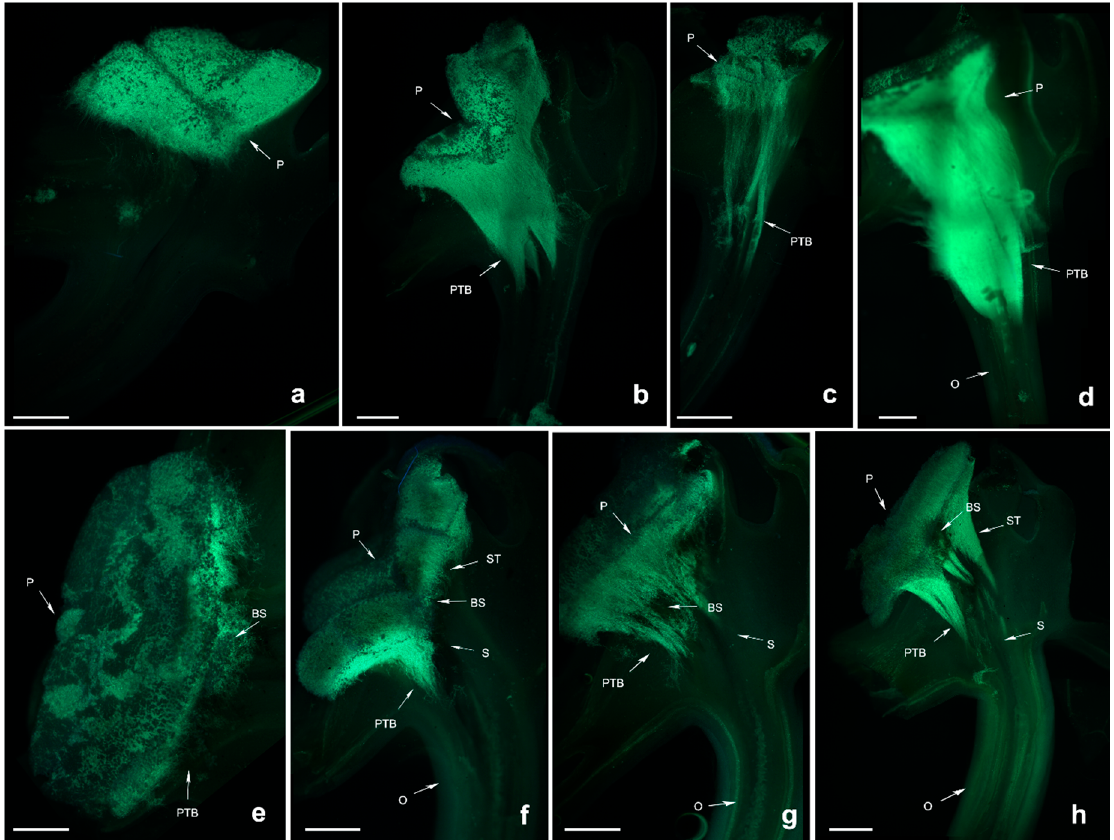
Figure 2. Growth of pollen tubes after self- and cross-pollination of Dendrobium lindleyi . P: pollinium; PTB: pollen tube bundle; BS: black spots; O: ovary; ST: stigma; S: style. ( a ) 24 h after cross-pollination; ( b ) 36 h after cross-pollination; ( c ) 48 h after cross-pollination; ( d ) 72 h after cross-pollination; ( e ) 24 h after self-pollination; ( f ) 36 h after self-pollination; ( g ) 48 h after self-pollination; ( h ) 72 h after self-pollination. Bars = 300 µm.